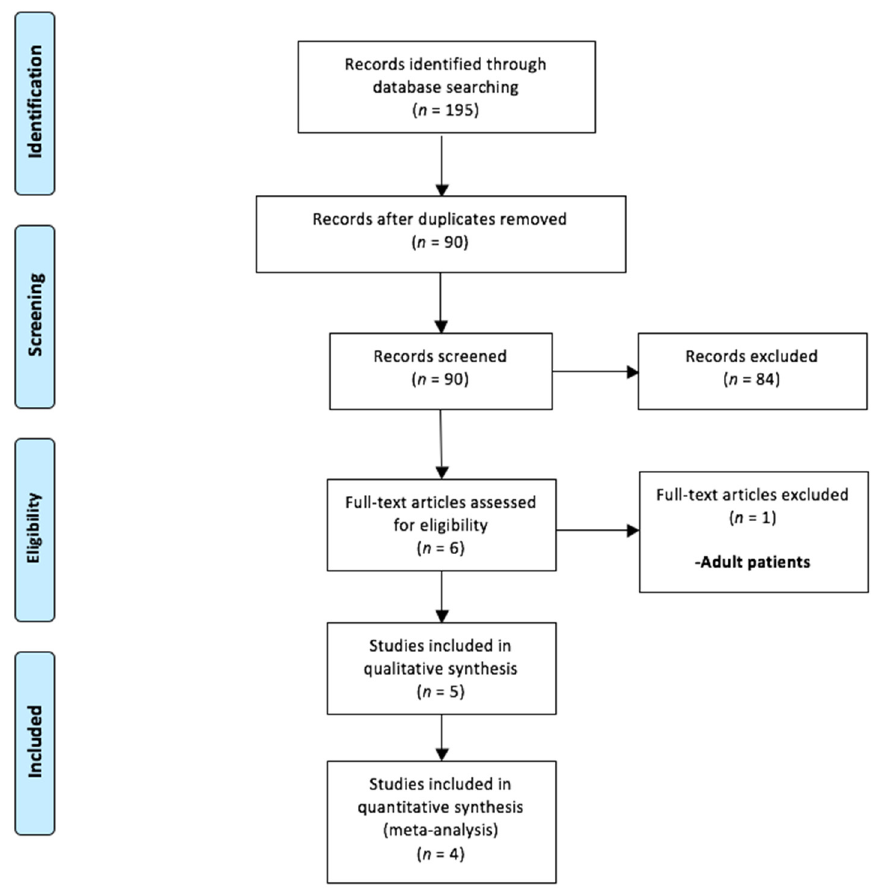
Figure 1. Selection of relevant studies using the Preferred Reporting Items for Systematic Review and Meta-Analysis (PRISMA) flow diagram.